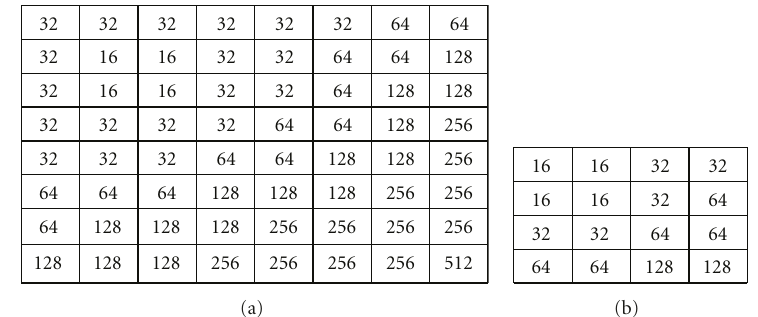
Figure 9: (a) The modified R quantization table. (b) The modified G quantization table.